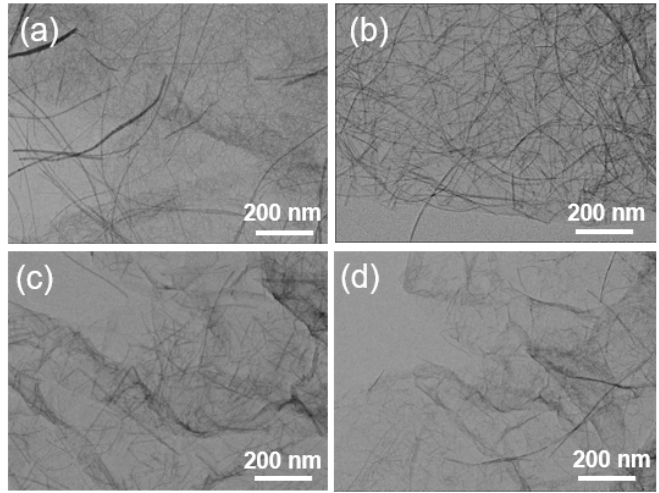
Figure 1. ( a – d ) TEM images of W 18 O 49 NWs/rGO composites with different weight ratios. ( a ) 0.2%, ( b ) 0.5%, ( c ) 1%, ( d ) 1.5%.